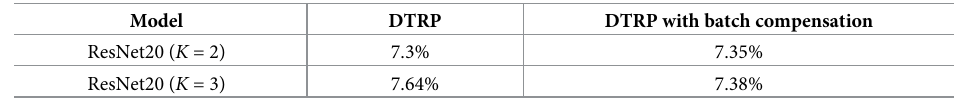
Table 8. Top-1 errors of